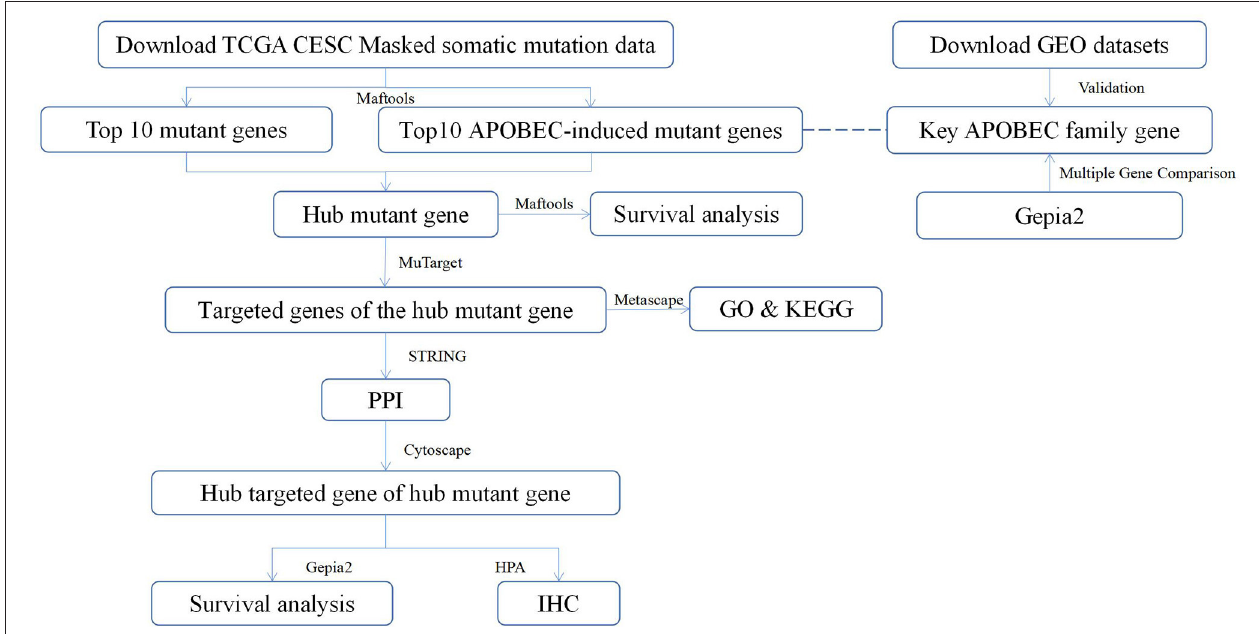
FIGURE 1 | The workflow of the study. TCGA, The Cancer Genome Atlas; CESC, cervical squamous cell carcinoma; Maftools, a package in R language; MuTarget, an online platform, which could help us to identify the gene(s) showing altered expression in samples harboring a mutated input gene or identify mutations resulting in the expression change in the input gene (https://mutarget.com/); GO, gene oncology; KEGG, Kyoto Encyclopedia of Genes and Genomes; STRING, functional protein association networks platform (https://cn.string-db.org); PPI, protein–protein interaction; Cytoscape, an open-source software platform for dynamic, graphical visualization, manipulation, and analysis of networks; Gepia2, an online analysis platform based on TCGA database (http://gepia.cancer-pku.cn/); HPA, human protein atlas (https://www.proteinatlas.org) GEO, Gene Expression Omnibus; IHC,